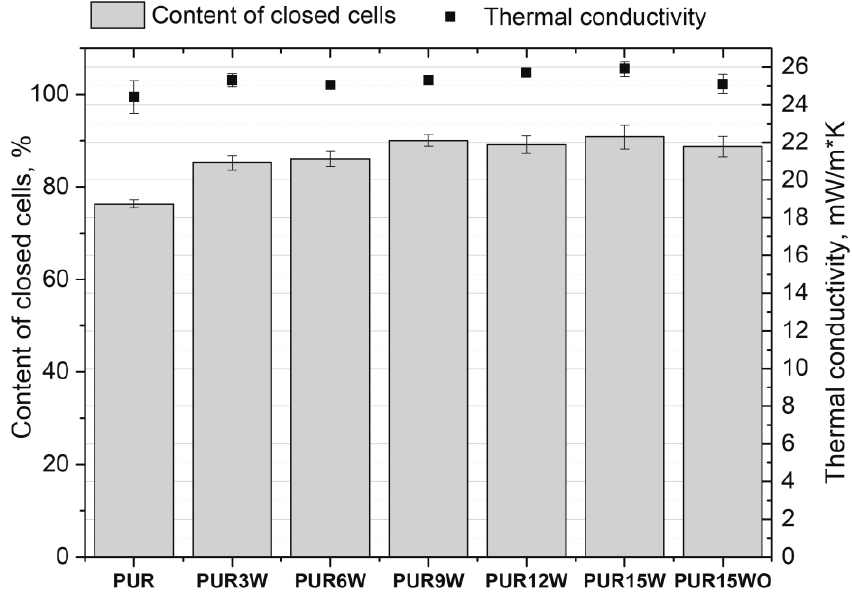
Figure 7. Content of closed cells and thermal conductivity of foams modified with vermiculite.